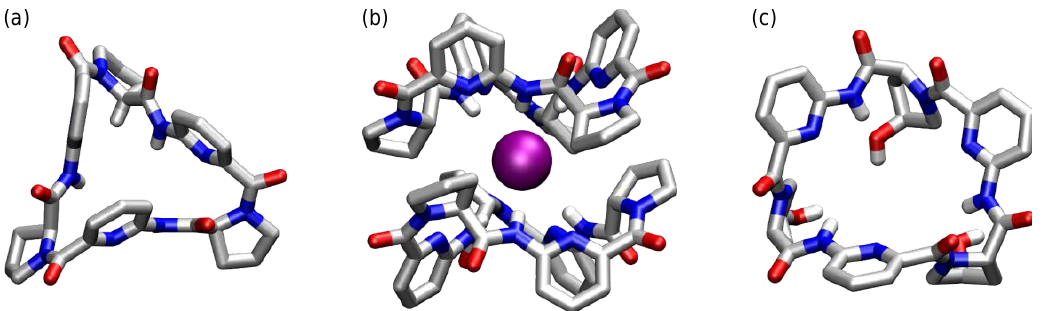
Figure 9. Crystal structures of 16a (CSD Entry: TIFKIC) ( a ), the sandwich-type iodide complex of 16a (CSD Entry: TIFKOI) ( b ), and of 16c (CSD Entry: XITDIN) ( c ). Solvent molecules, counterions, and protons, except acidic ones, and the H( α ) protons in ( a ) are omitted for reasons of